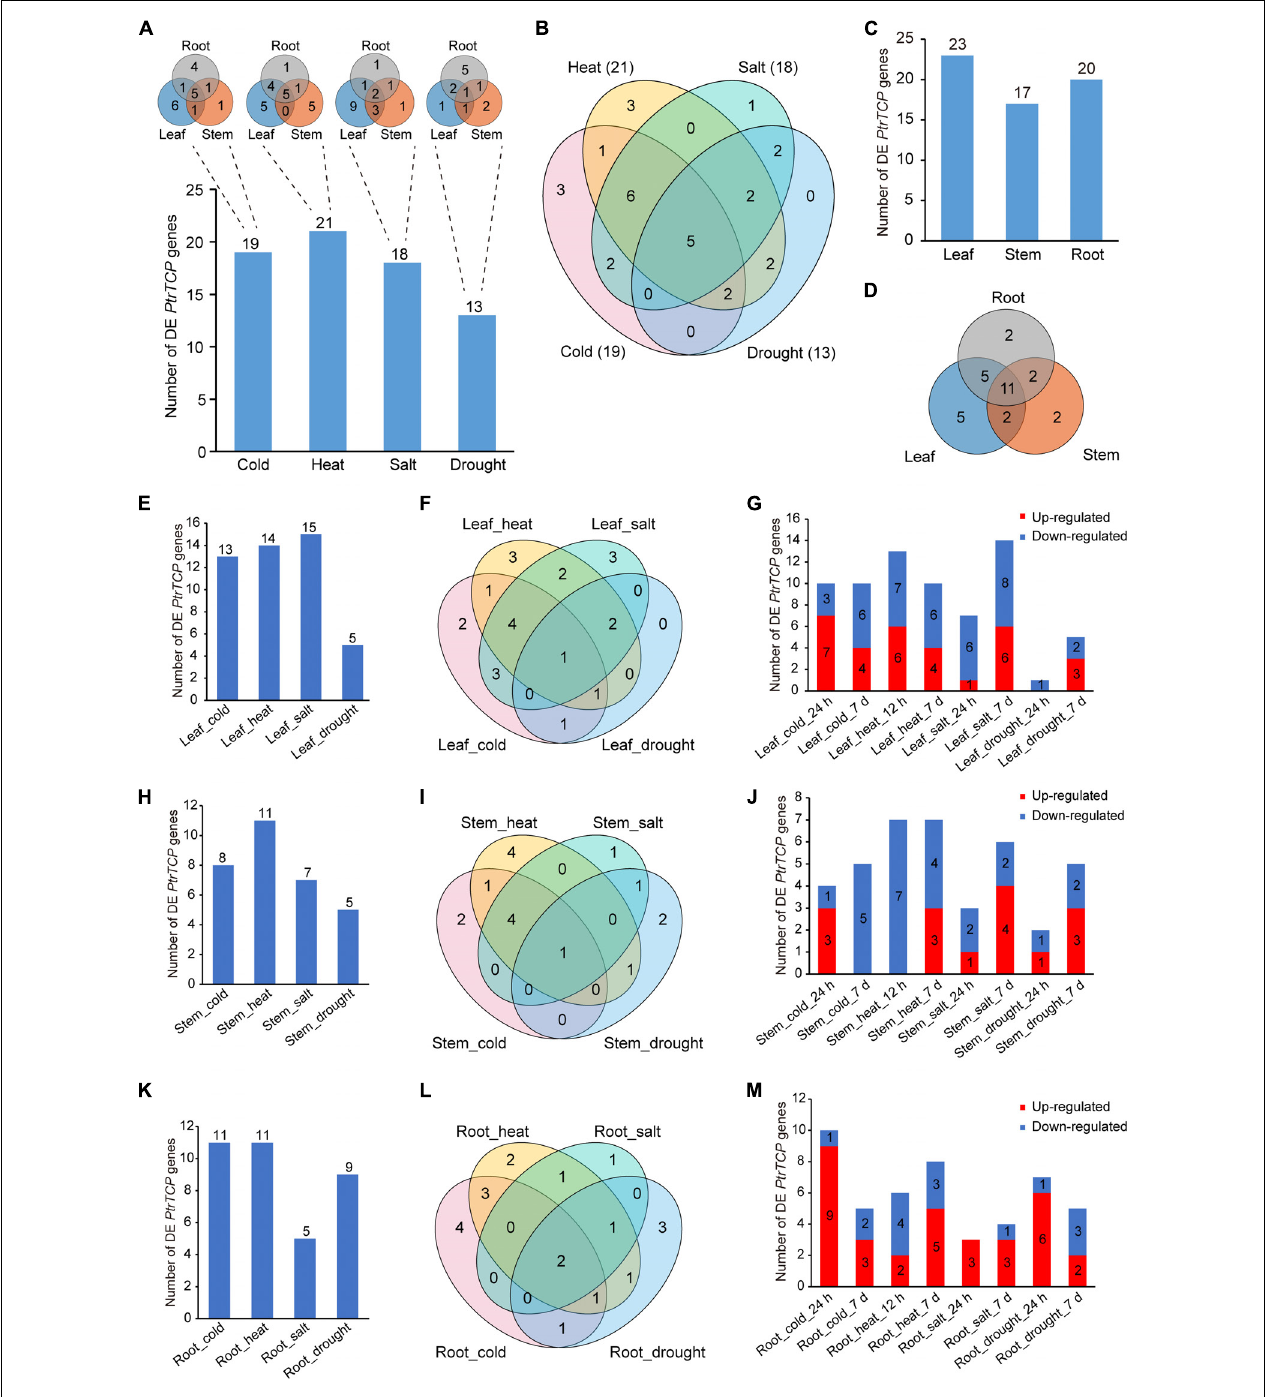
FIGURE 5 | Identification of the differentially expressed (DE) PtrTCP genes that could significantly respond to abiotic stresses. (A,B) The DE PtrTCP genes in response to different abiotic stresses. (C,D) The DE PtrTCP genes in response to abiotic stresses in different tissues. (E–M) The DE PtrTCP genes in response to abiotic stresses in leaf (E–G) , stem (H–J) , and root (K–M) .